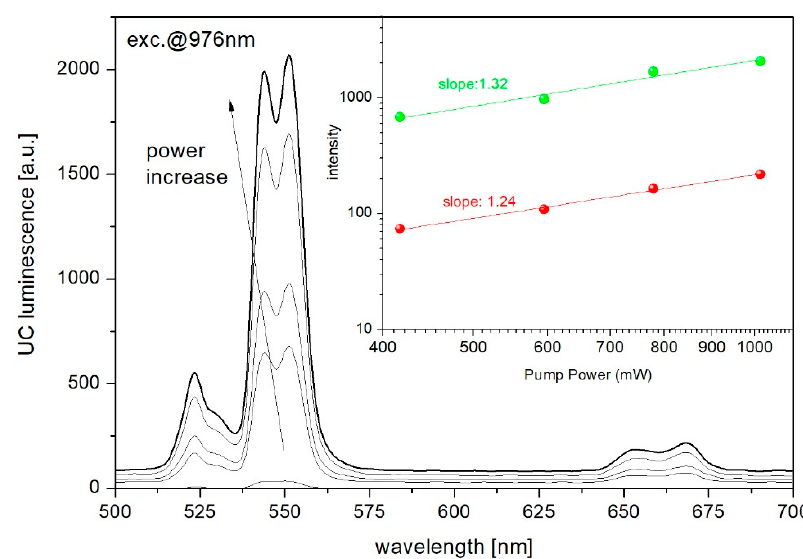
Figure 16. The energy scheme.